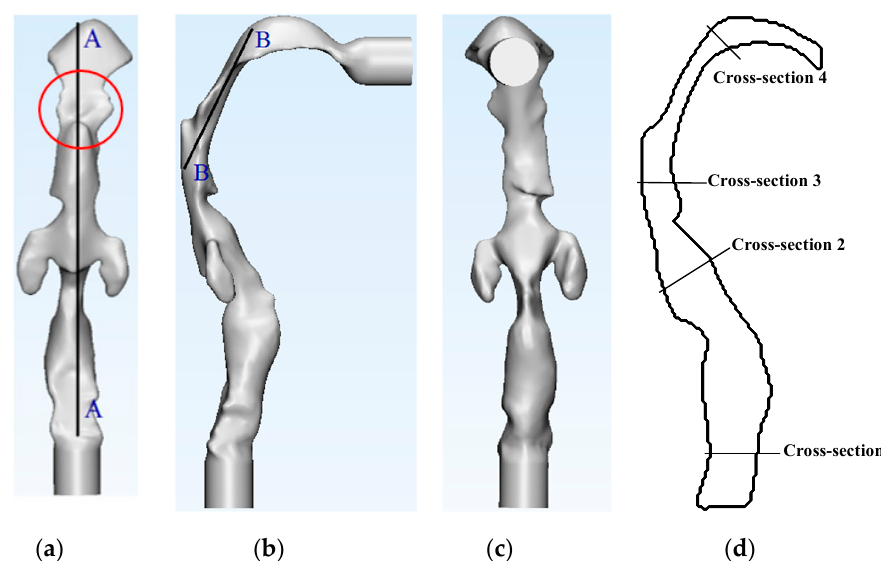
Figure 2. Reconstructed ETA model with OSAHS: ( a ) dorsal view; ( b ) lateral view; ( c ) front view; ( d ) four cross-sections.